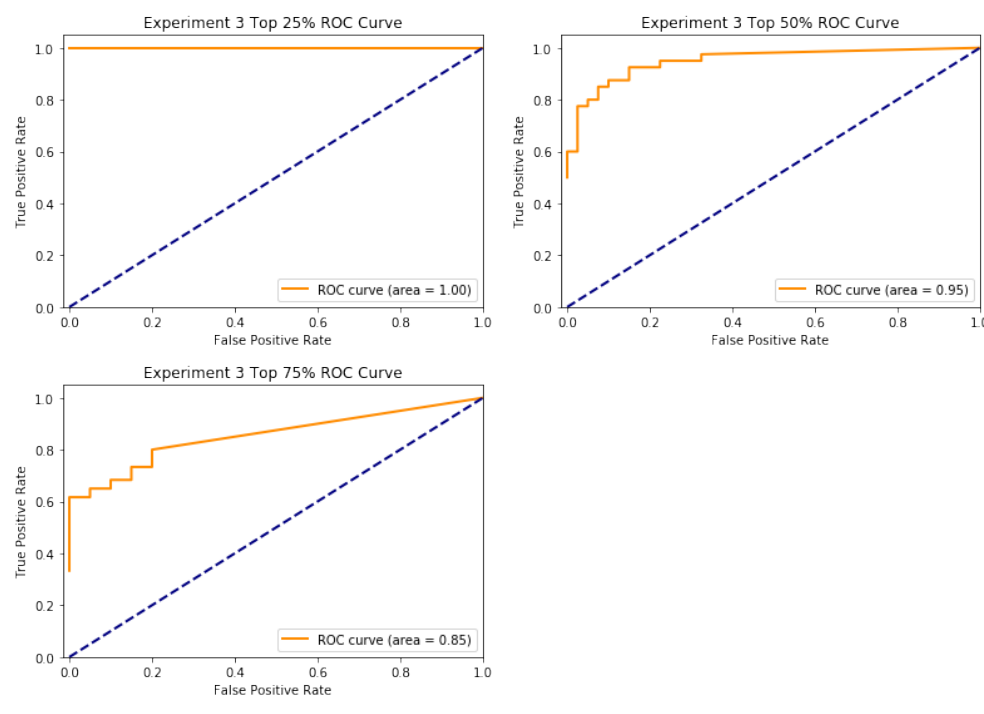
Figure 13. Experiment 3 ROC